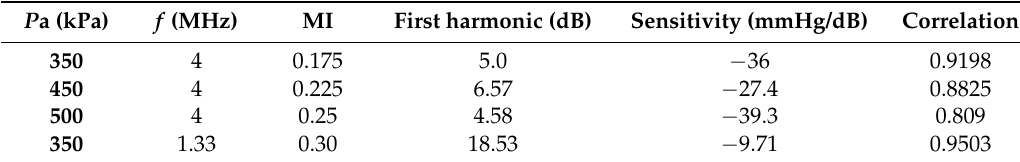
Table 1. Ambient pressure sensitivity of the first harmonic amplitude.